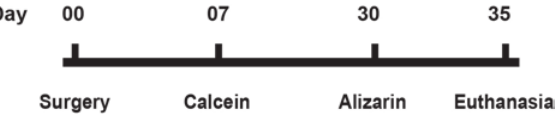
Figure 3- Schematic presentation of the application of calcein (7th postoperative day) and Alizarin (30th postoperative day) application (20 mg/kg body weight, IM)